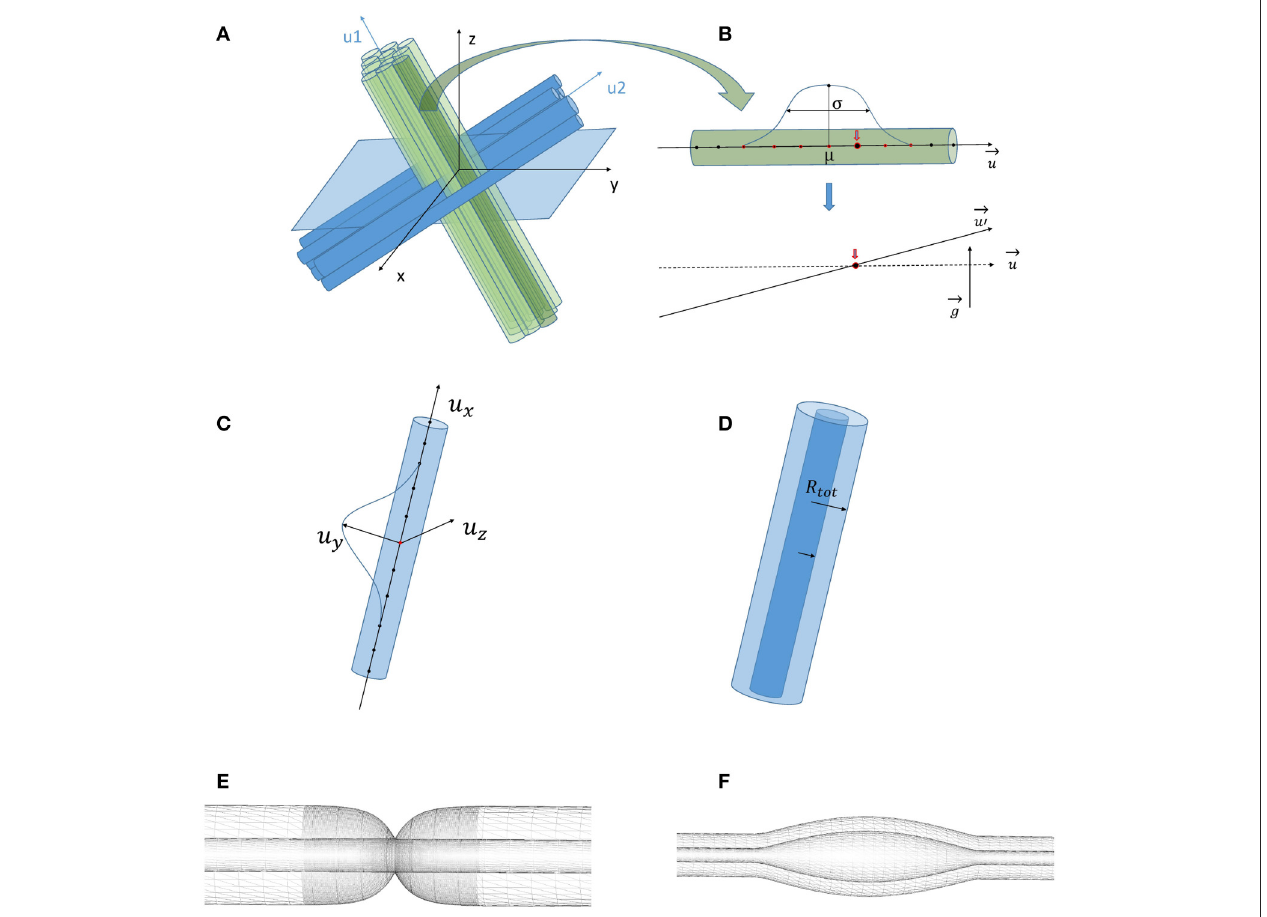
FIGURE 1 | (A) Phantom generation for two populations (blue and green) with orientations u i (B) . Global angular dispersion is created by selecting randomly an axon among a given fiber and a point on this axon which will be the center of rotation of the fiber. The selection of the rotation center follows a Gaussian distribution with mean µ and variance σ . A perturbation vector g whose components follow a Gaussian distribution with a variance proportional to the target angular dispersion is added to the orientation vector u , resulting in a rotation around the selected fixed point and in a new orientation vector u ′ . (C) Local angular dispersion is induced by deforming each axon separately. A point on the axon (in red) and a direct trieder ( u x , u y , u z ) are chosen randomly. u y defines the direction of the tortuosity deformation whose amplitude follows a Gaussian distribution with a variance depending on the number of points which are affected by the deformation around the central red g . R tot ( g is the g -ratio) is created which represents the point. (D) Creation of the myelin sheath. Inside each cylinder of radius R tot , an inner cylinder of radius R = axonal membrane, and the external cylinder represents the outer layer of myelin sheath. (E) Creation of Ranvier nodes. The resolution of the fiber mesh around each Ranvier node is refined to better account for the exponential decay of the myelin thickness around the node. (F) Beading generation. Both the axonal contour (inner mesh) and the myelin sheath (external mesh) are swollen with a sine function. The myelin sheath thickness is preserved since beading comes from the swelling of the axonal membrane due to